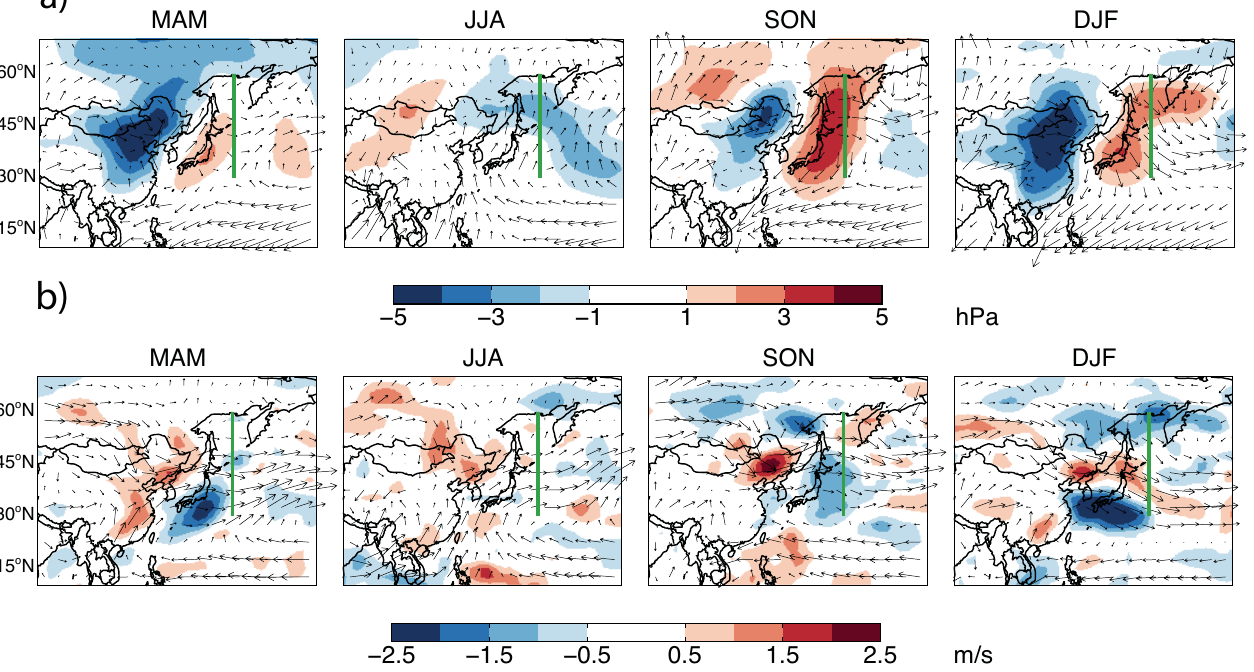
Fig. 5. Seasonal composites of meteorological fields anomalies 2 days before E. Asian LRT + events relative to the seasonal means for 2004- 2010. Top: sea level pressure anomalies (filled contours) and surface wind fields (arrows indicate direction and speed). Bottom: 850hPa wind speed anomalies (filled contours) and wind fields